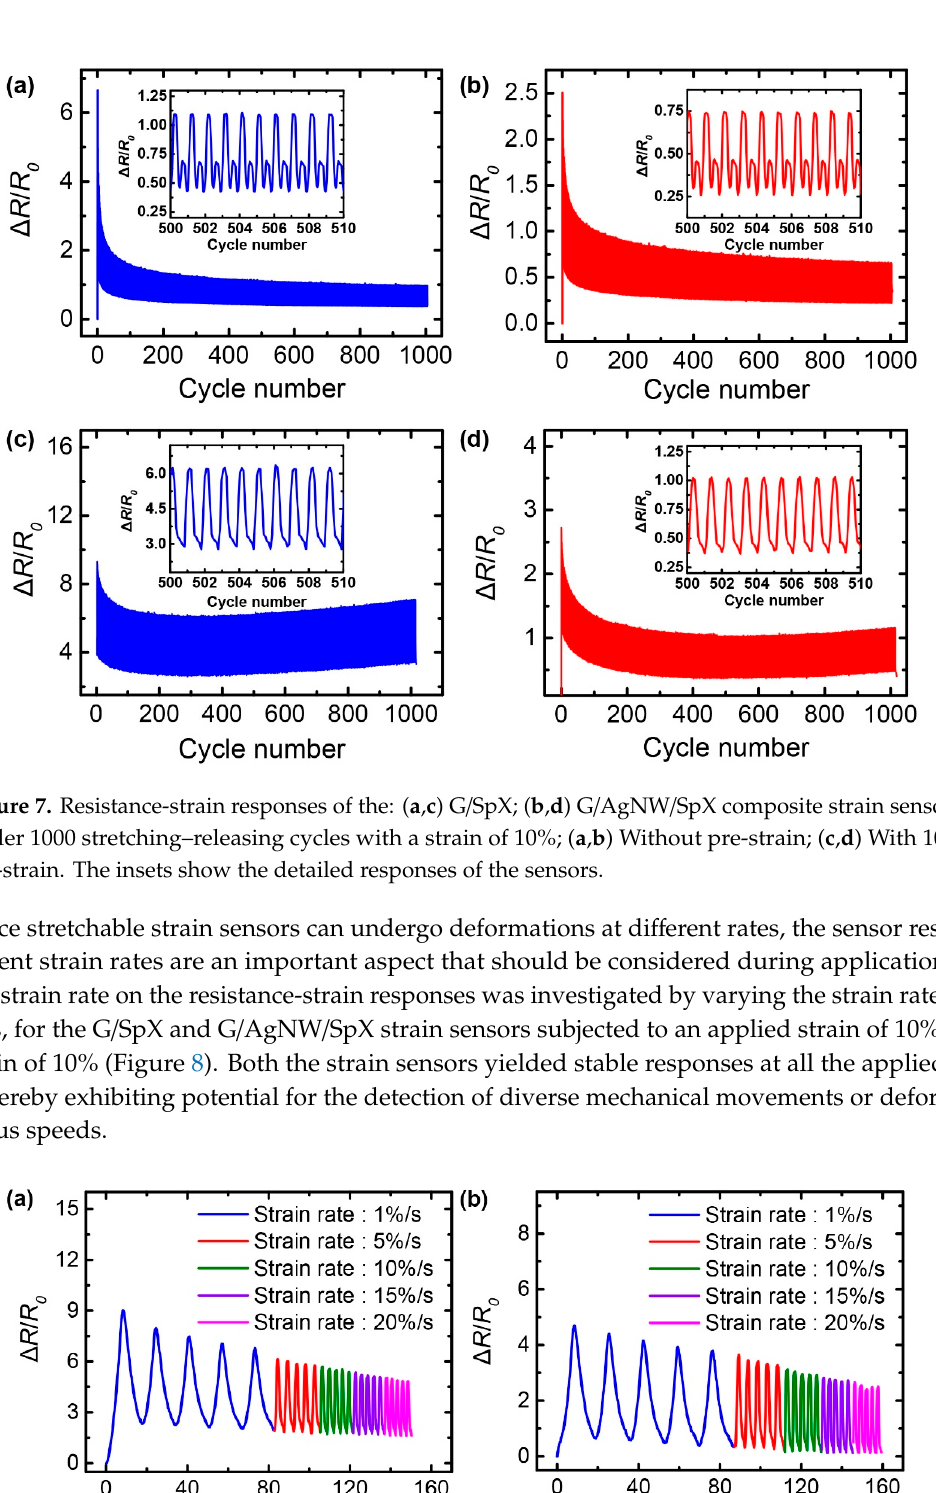
Figure 8. Resistance-strain responses of the: ( a ) G/SpX; ( b ) G/AgNW/SpX composite strain sensors at various strain rates, with a strain of 10%. The pre-strain of 10% was applied to the sensors.